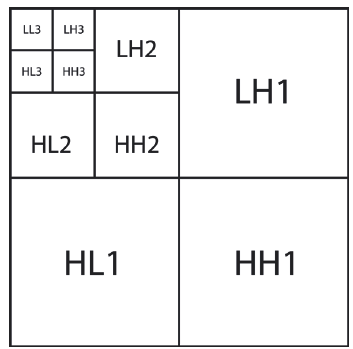
Fig. 3. Channels resulting from the decomposition of 3